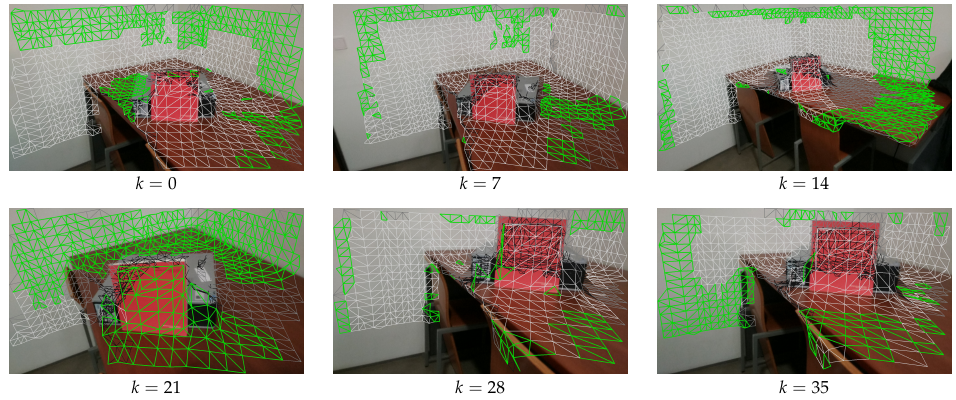
Figure 12. Largest projected face area criteria for selecting the faces; Color notation is the same as in Figure 10.